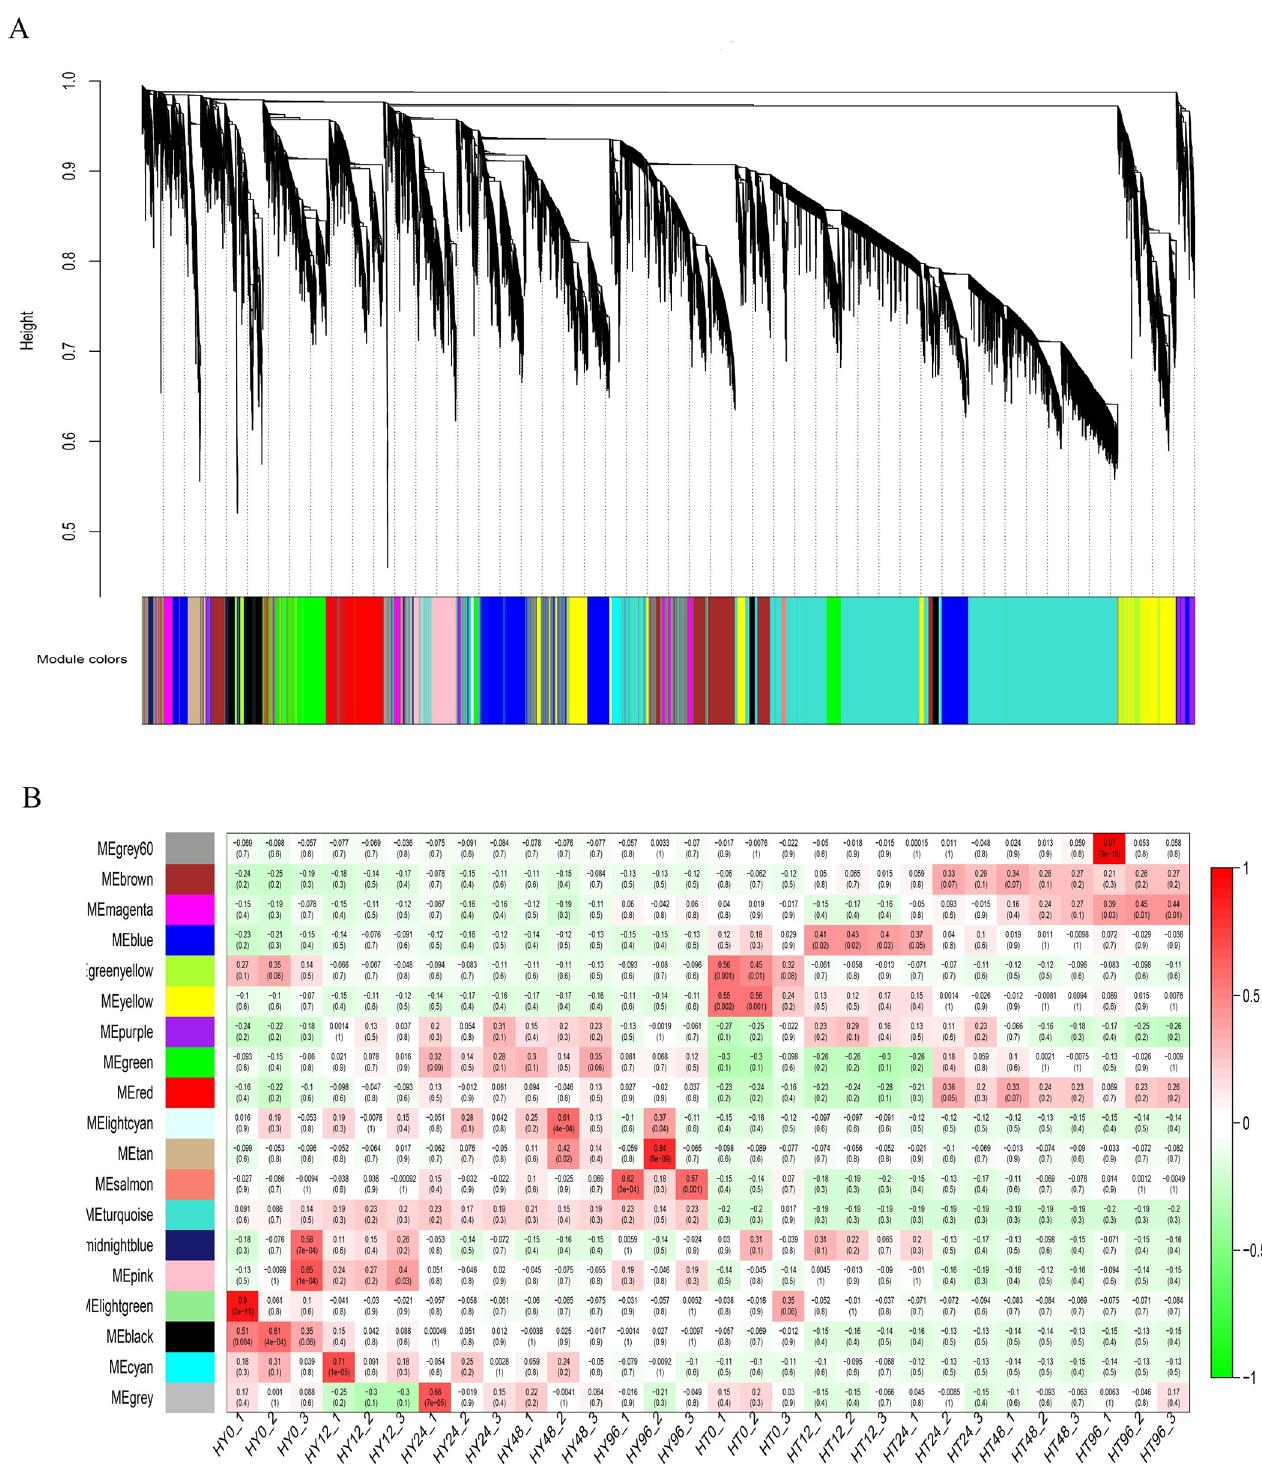
Fig 4. Gene co-expression network analysis with weighted gene co-expression network analysis (WGCNA). (A) Gene Dendrogram colored according to the correlations between gene expression levels. A total of 19 different modules were obtained. Different colors represent different gene modules on the abscissa and the ordinate indicates coefficients of dissimilarity between genes. (B) Module-sample association. The abscissa represents samples and the ordinate represents modules. The numbers in the cells are the correlation coefficient (top) and P-value (bottom). The variation from green (low) to red (high) indicates ranges of the